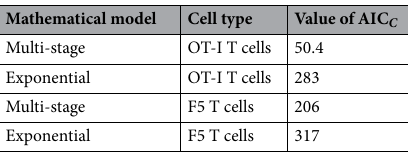
Table 2. AIC C values for the exponential and multi-stage models calibrated with CFSE data of murine T lymphocytes.